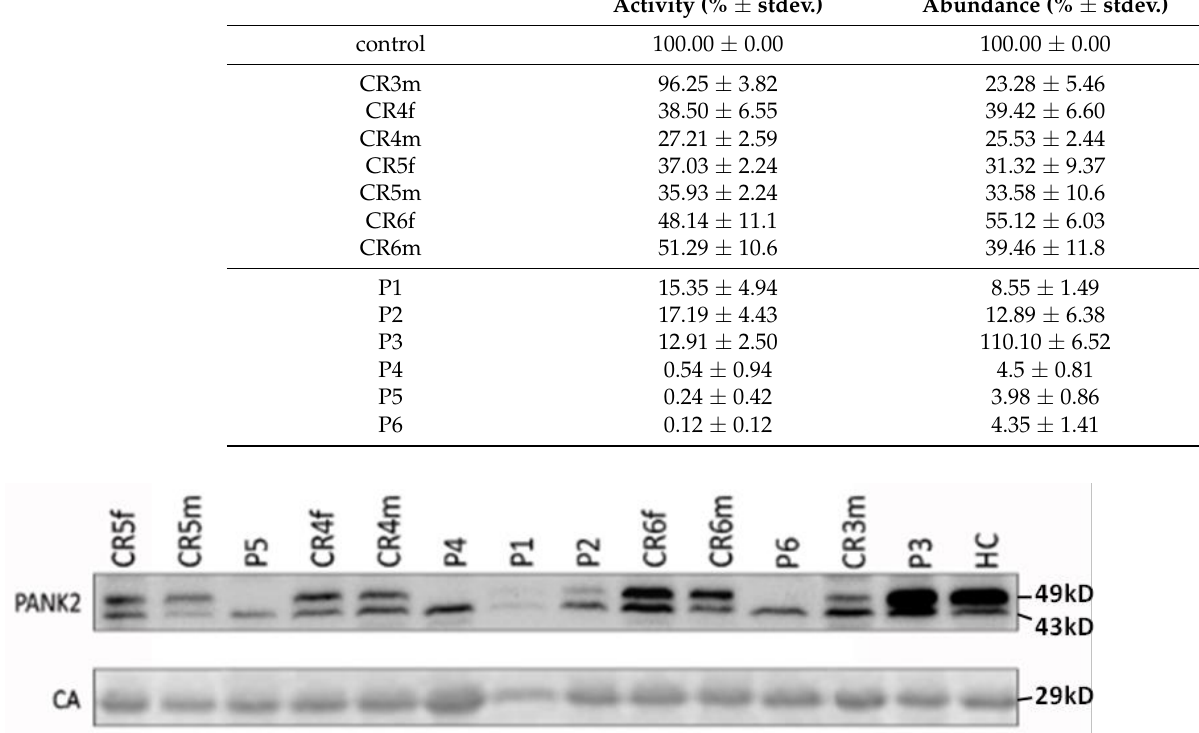
Table 2. PANK2 activities and abundances in erythrocyte of PKAN patients and carriers. Erythrocyte cytosolic extracts of a healthy donor (control), carriers (CR3-CR6 (f/m denotes father or mother of re- spective patient)), and PKAN patients (P1–P6) were assayed by radiometry for phospho-pantothenate generation described in Section 2. Specific PANK2 activities per total protein were determined and relative PANK2 activities were calculated from the specific activities by normalization to the specific activity of the control donor. Erythrocyte cytosolic extracts of the same set of blood samples were depleted of hemoglobin concentrated and analyzed by SDS PAGE and Western blotting for the abundance of PANK2 protein as described in Section 2. Specific PANK2 abundances were deter- mined in relation to carbonic anhydrase and relative PANK2 abundances were again calculated by normalization to that of the control donor. All values are mean values ( n = 3) given in relative percent plus/minus standard deviations (stdev.). Activity (% ± stdev.) Abundance (% ± stdev.)